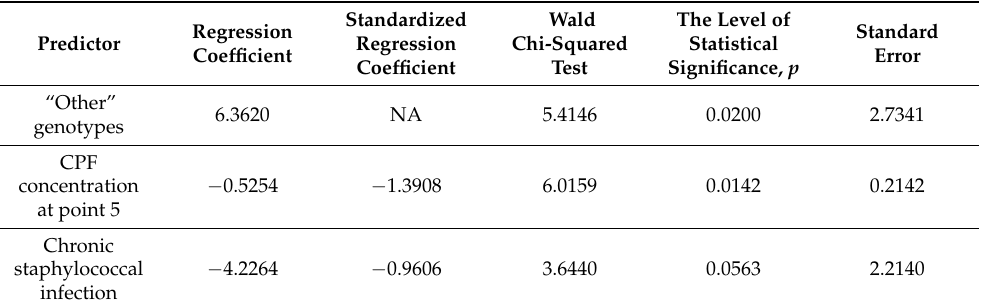
Table 15. Estimated logistic regression parameters based on CPF concentration in patients with different genotype variants of GCLC gene.